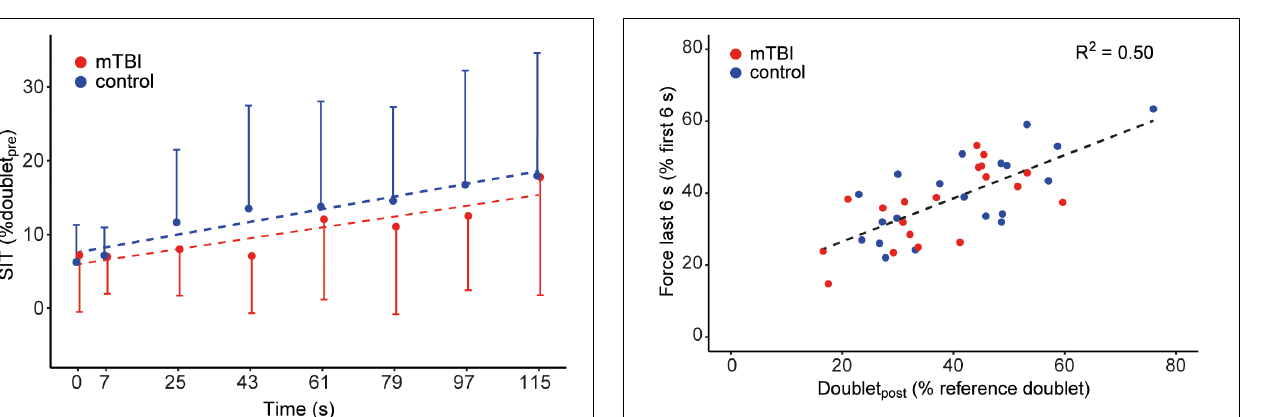
FIGURE 6 | Association between force decline during the sustained MVC and the evoked doublet-force after the sustained contraction (i.e., doublet post ) showing that participants with greater force decline also showed a greater decline in electrically evoked force. Control participants ( n = 20) are shown in blue and mTBI ( n = 19) in